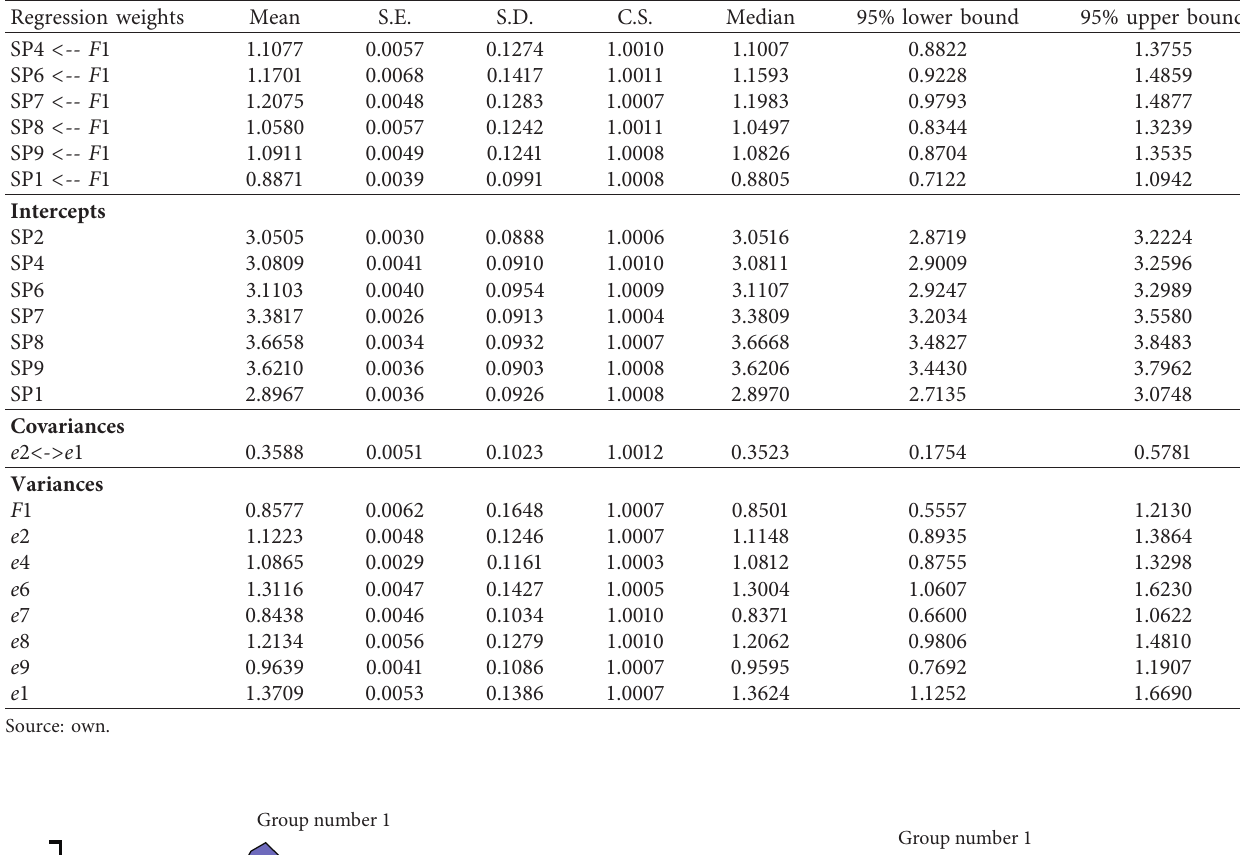
Table 5: Bayesian parameters.